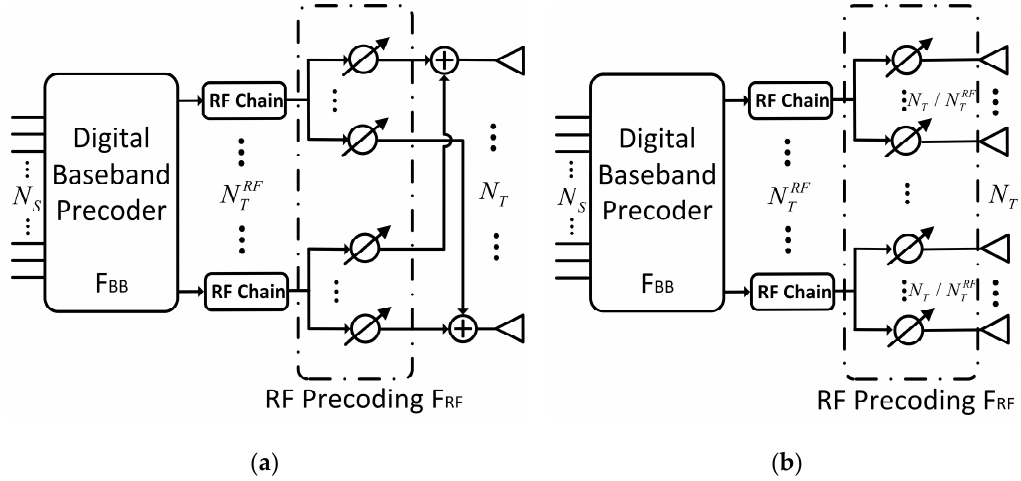
Figure 1. ( a ) Fully-connected hybrid precoding structure; ( b ) partially-connected hybrid precoding